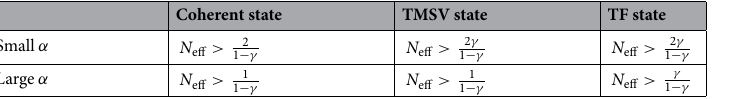
Table 1. Conditions of N eff such that SNR > 1 for the coherent, TF and TMSV state inputs, assuming η = 0 in good approximation due to its negligible contribution for moderate γ